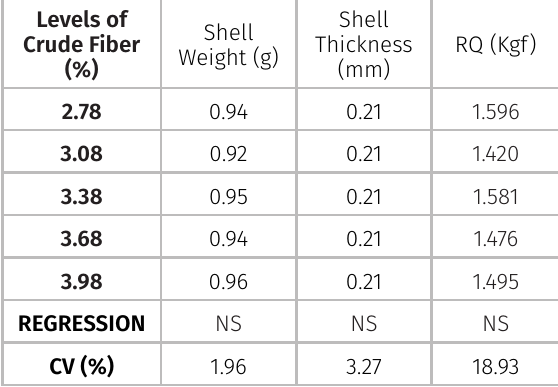
Table IV. Shell weight (g), shell thickness (mm) and breaking resistance in Kgf (RQ) of eggshell of Japanese quails fed diets containing different levels of crude fiber. Shell Levels of Shell Thickness RQ (Kgf) Crude Fiber Weight (g) (mm) (%)